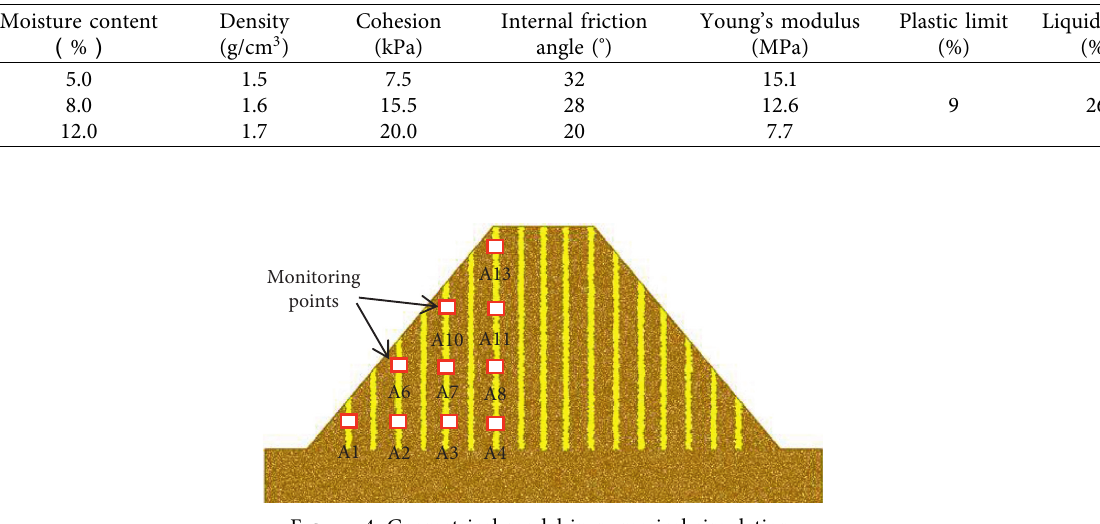
Table 1: Physical and mechanical parameters of soil.